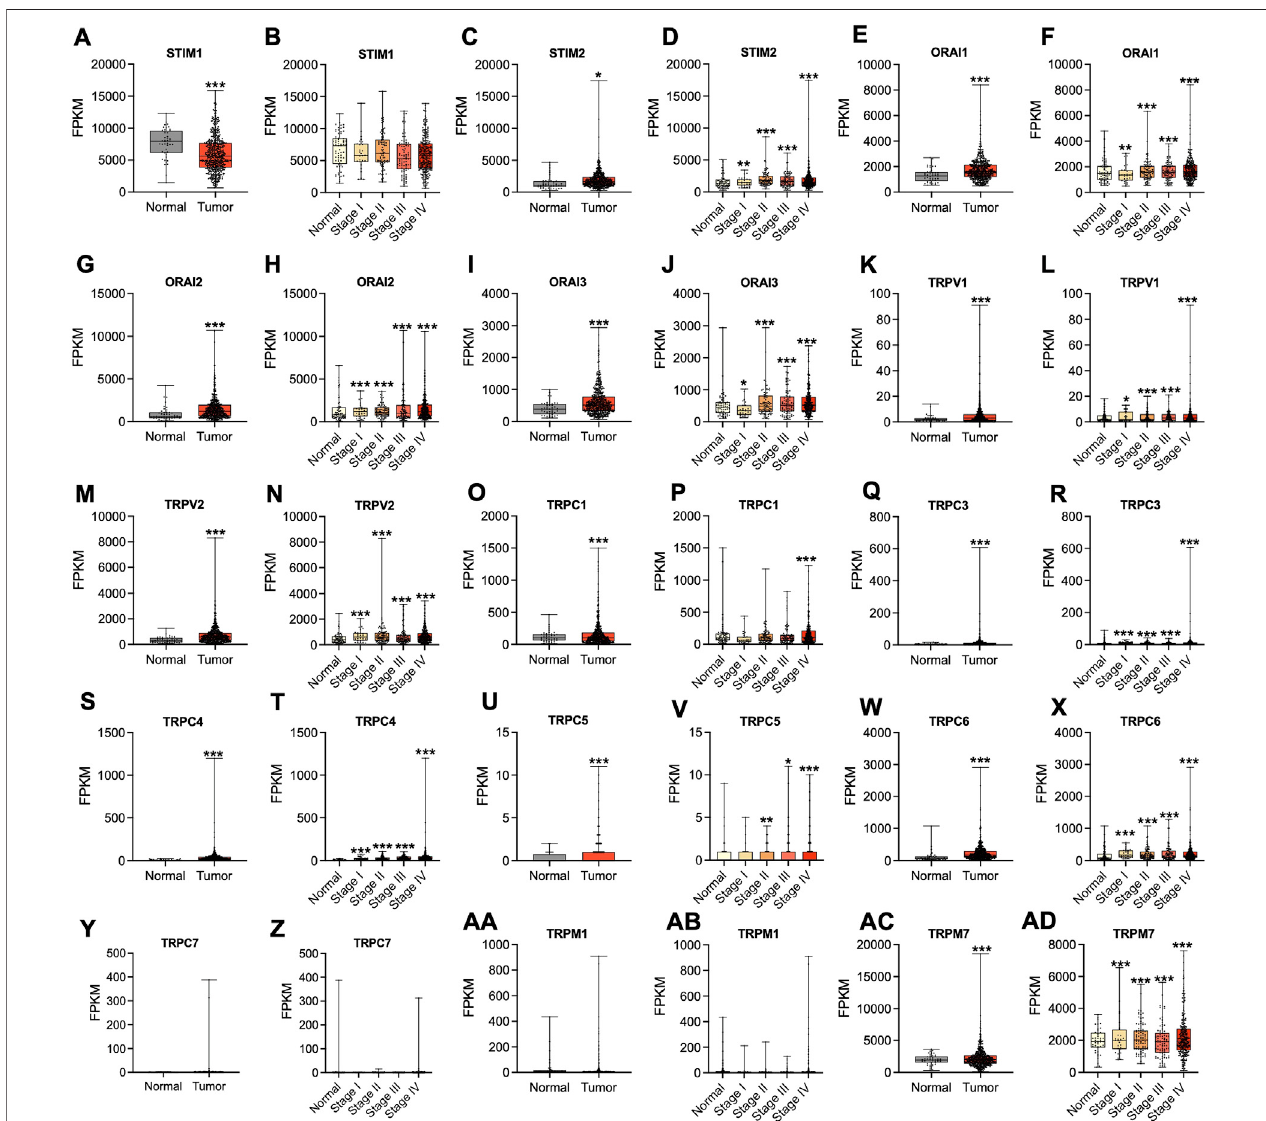
FIGURE 3 | Altered mRNA expression of SOCs in HNSC. The Hiseq2 gene expression and clinical details of TCGA-HNSC data was downloaded from the TCGA biolinks – Bioconductor package for R statistical environment. The expression levels of SOCs (represented as fragments per kilobase per million mapped fragments- FPKM)innormalversustumor (A,C,E,G,I,K,M,O,Q,S,U,W,Y,AA,AC) anddifferentstages-stageI,stageII,stageIII,andstageIVofHNSC (B,D,F,H,J,L,N,P,R,T,V,X, Z, AB, AD) are plotted. The statistical signi fi cance is represented as * p < 0.05, ** p < 0.01, *** p <